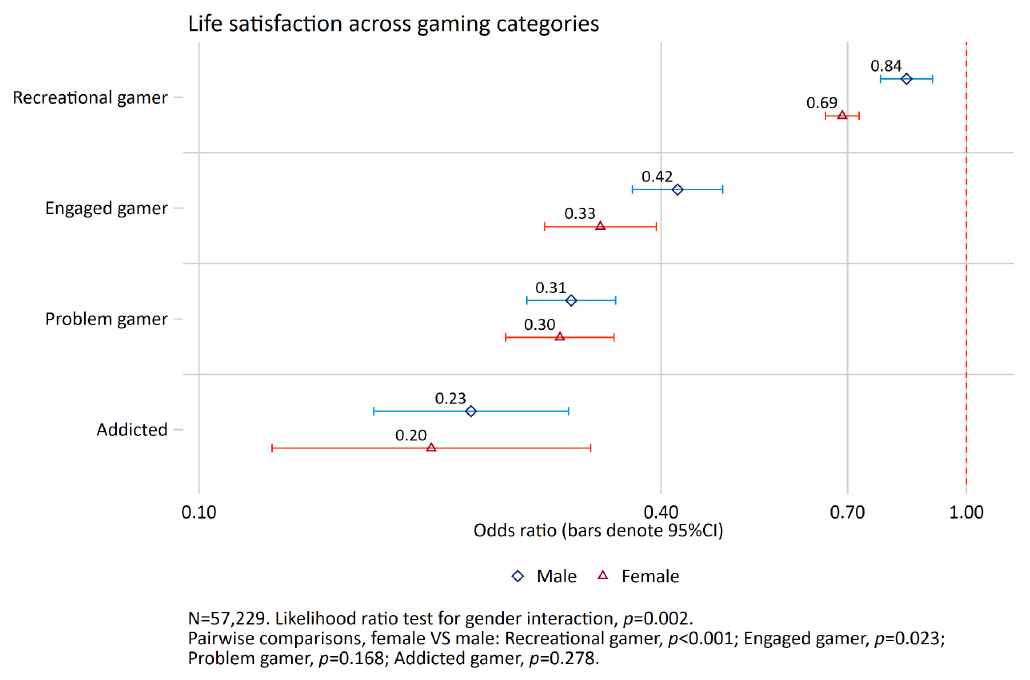
Figure 5. Association between gaming categories and life satisfaction. Results from logistic regres- sion analysis. Non-gamer as reference group. Adjusted for age, relationship status and living ar- rangements. The red dashed vertical line indicates odds ratio of 1 (no association).